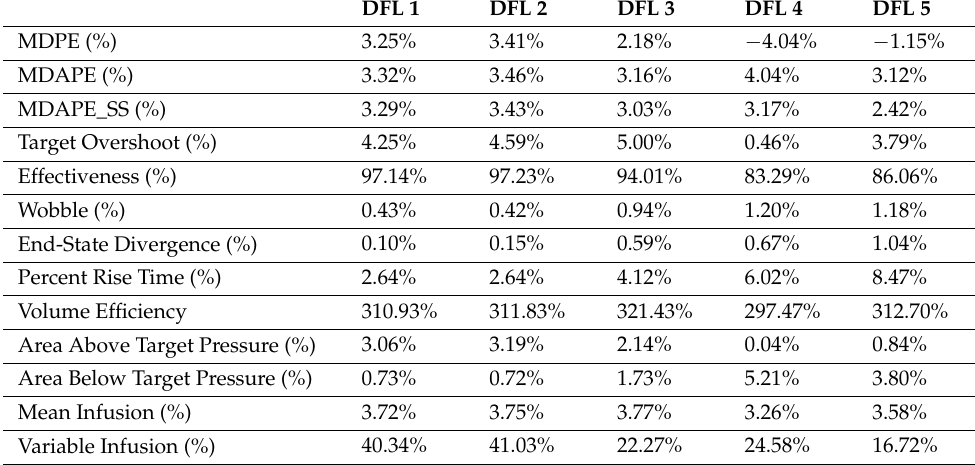
Table A1. Summary of performance metrics for Scenario 1. Performance metrics for each of five DFL controllers is shown as mean values for three subject variability runs.